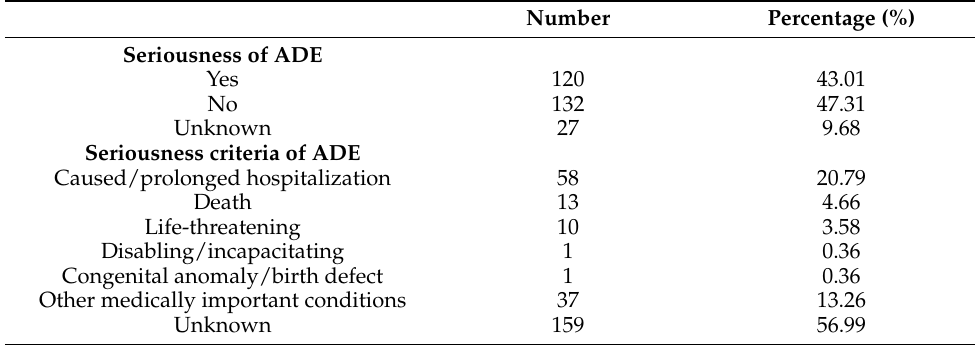
Table 3. Seriousness of antimicrobial-related ADEs.